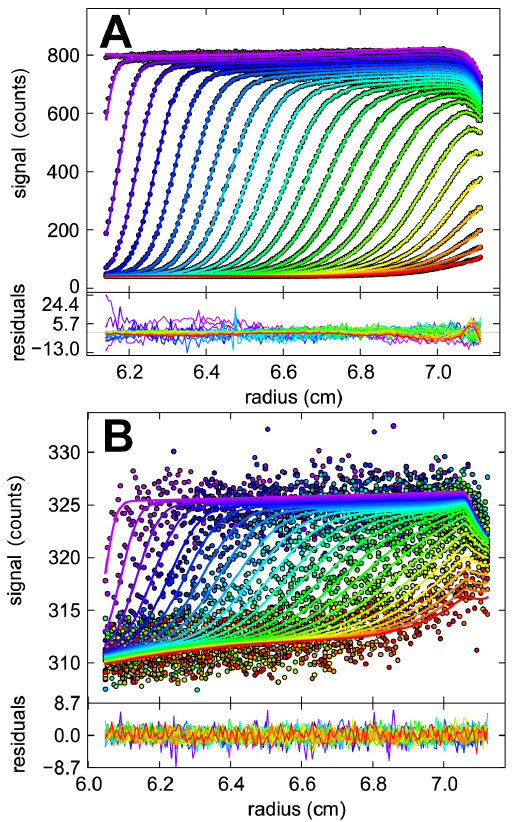
Figure 1. Examples of the evolution of radial signal profiles of GluA2 ATD. Circles are experimental data, for clarity showing only every 2nd data point of every 2 nd scan, and solid lines are the best-fit c ( s ) models, with increasing color temperature indicating later times. Residuals of the fits are shown in the small panels below the boundary profiles. (A) 300 nM of EGFP-GluA2 ATD, with a root-mean-square deviation (rmsd) of 2.6 signal units and a total signal of 755 units; (B) 1 nM Dylight488-GluA2 ATD with 9 nM unlabeled GluA2 ATD, with an rmsd of 1.566 signal units and a total signal of 13.9 units.